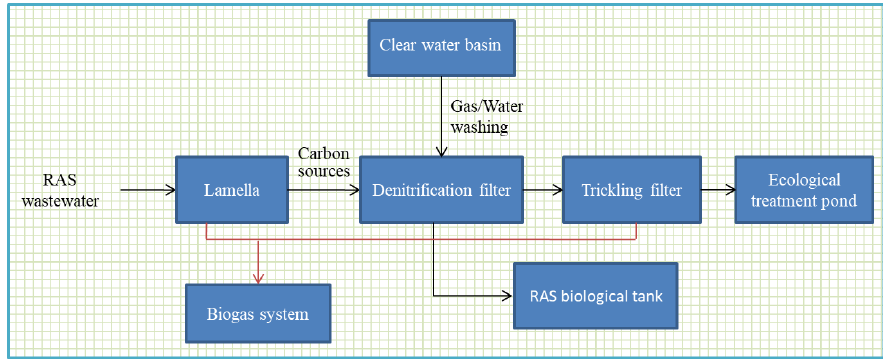
Figure 5. Schematic diagram of a combined denitrification filter and ecological pond.